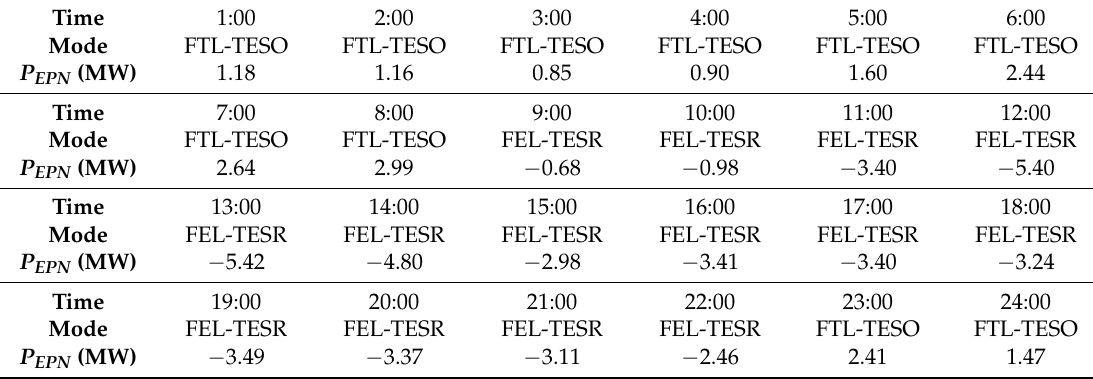
Table 5. CHP operation modes under the proposed control strategy in winter case ( C = 0.55).